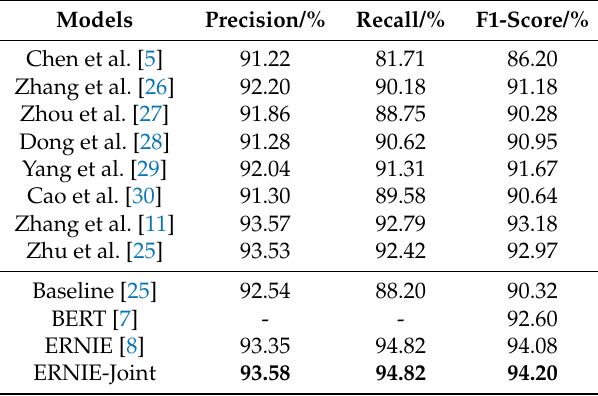
Table 5. The results on the